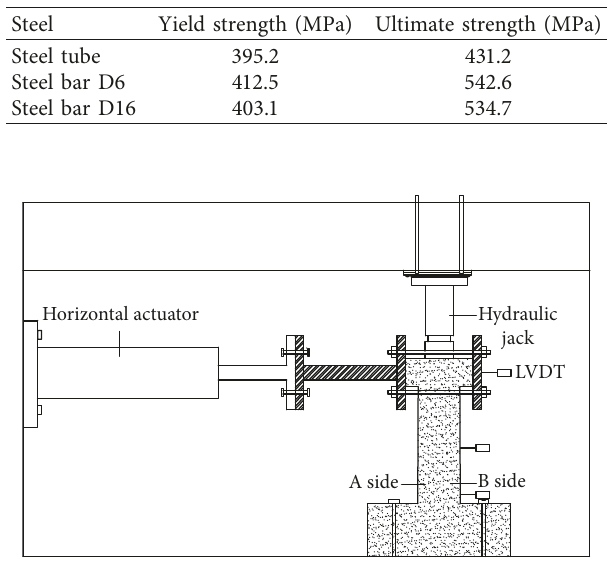
Figure 4: Concrete specimen test device.